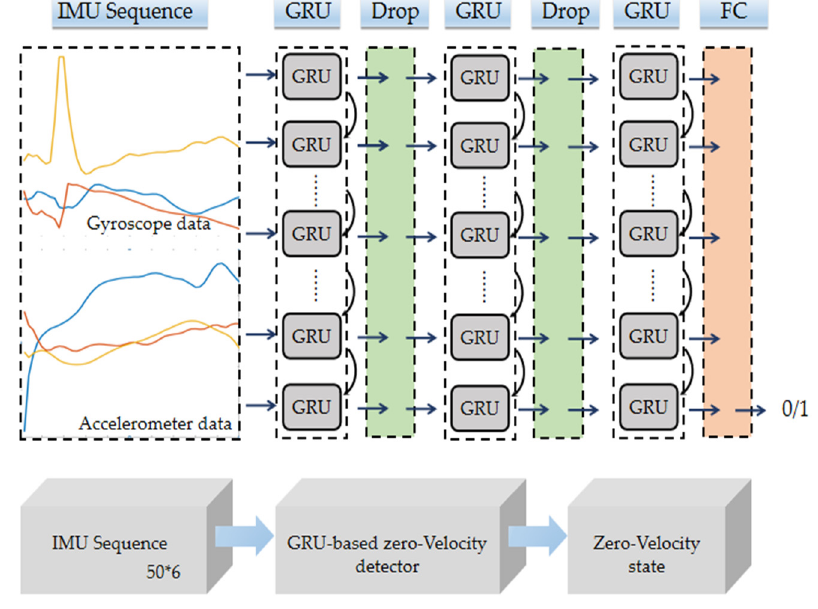
Figure 4. The structure of zero-velocity detection based on GRU.